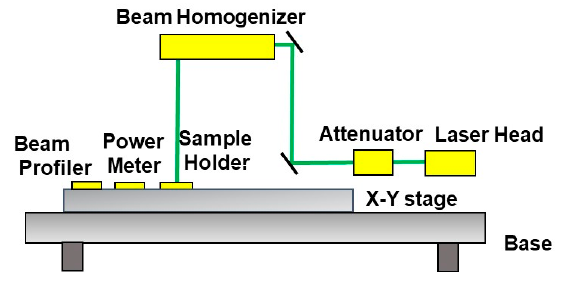
Figure 6. Schematic view of the new CLC equipment.